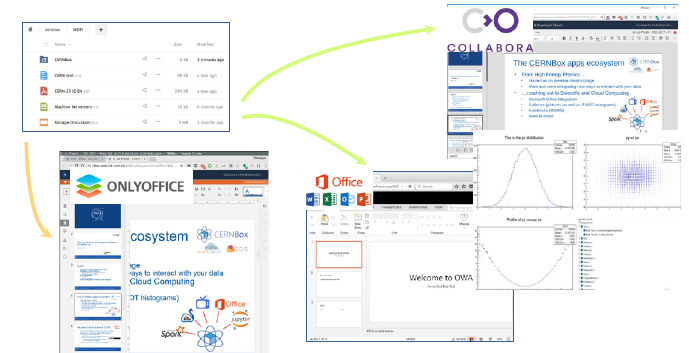
Figure 8. Integration of CERNBox with O ffi ce-like services